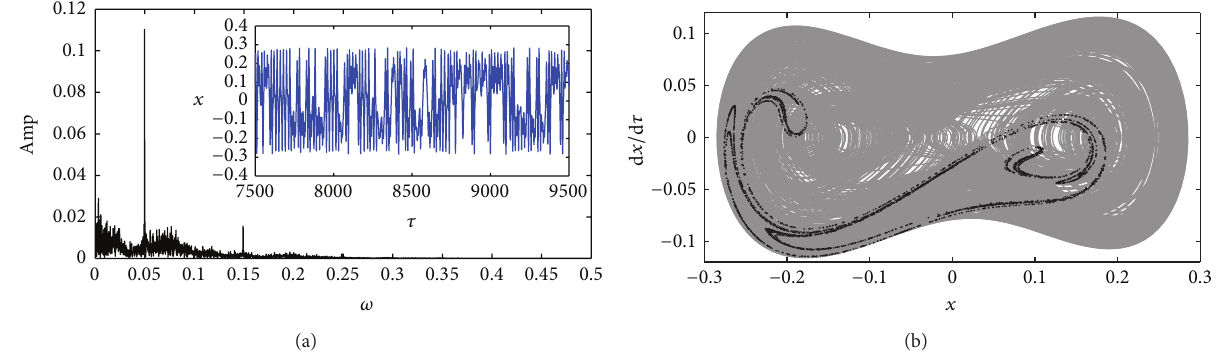
Figure 10: Chaotic response of the system for 𝜔 𝑒 = 12 Hz and 𝑍 𝑒 = 2.24𝑔 : (a) time series and frequency spectrum and (b) phase plot and Poincar´e